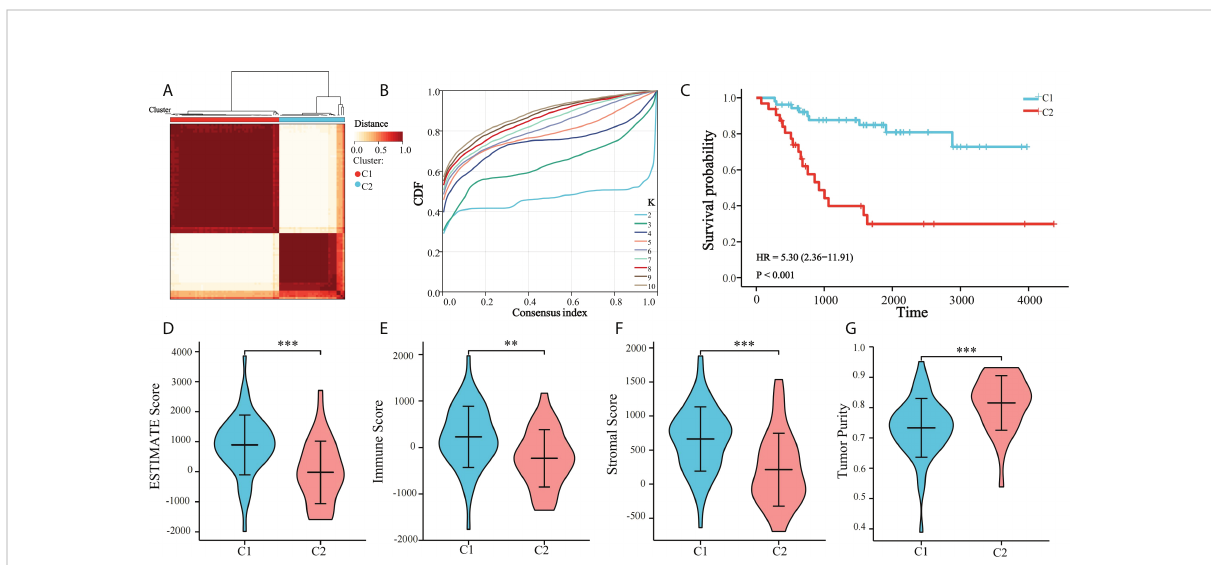
FIGURE 1 Unsupervised clustering of PRGs. (A) Clustering heatmap of prognosis-related platelet genes, 85 samples of TCGA were divided into 2 groups (K = 2); (B) Consensus Cumulative Distribution Function (CDF) plot under k = 2 – 10, where the number of k represents the number of groups after unsupervised clustering; and (C) Survival of patients in C1 and C2; (D – G) ESTIMATE Score, Immune Score, Stromal Score, Tumor Purity of C1 and C2 (**p < 0.01, ***p <